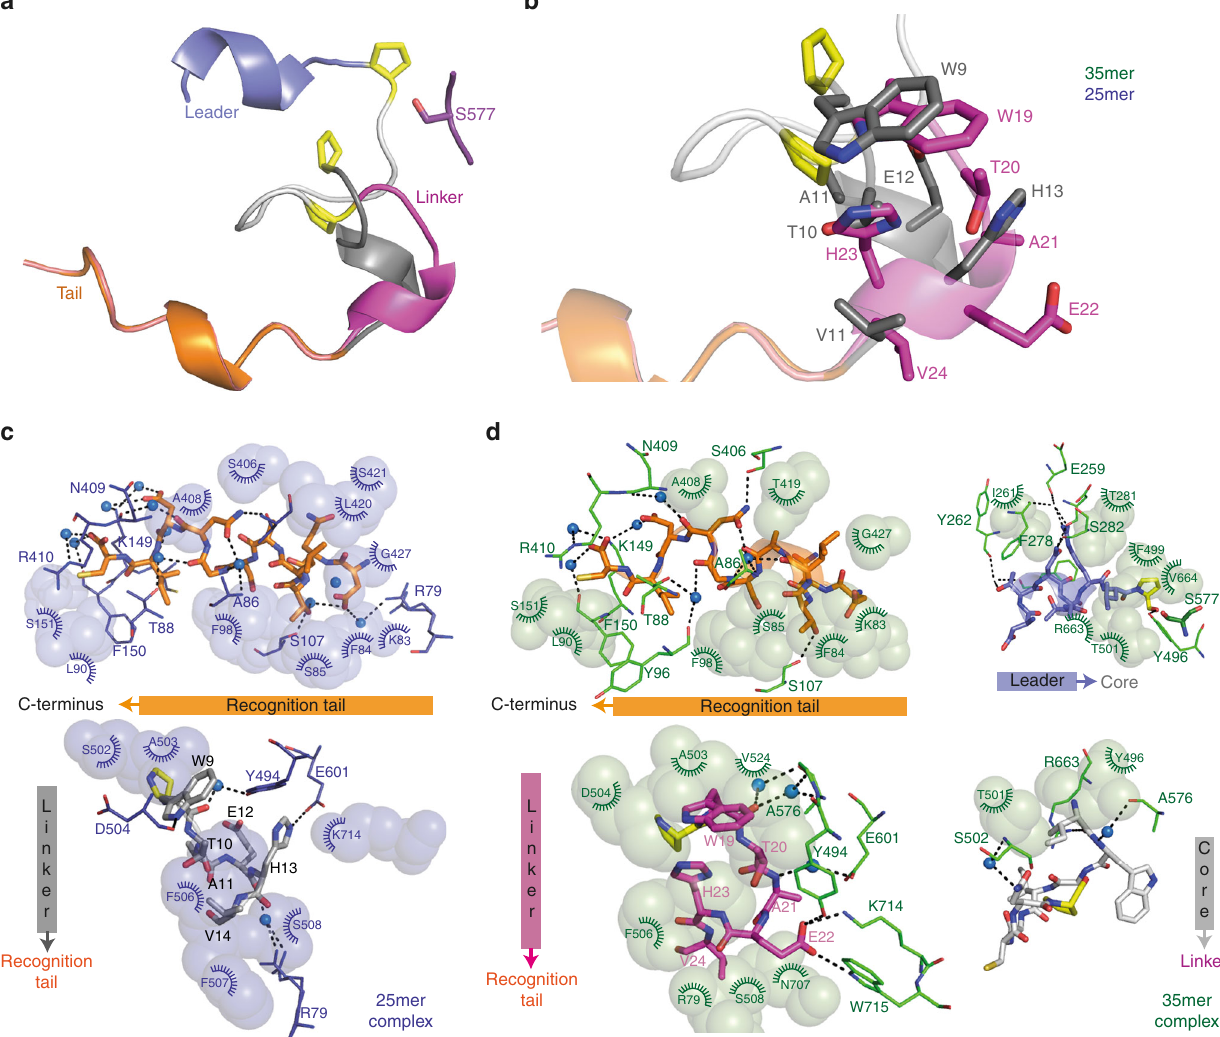
Fig. 2 Interactions between GmPOPB and linker regions for 35mer and 25mer substrates are different. a Overview of bound peptides. Colors for distinct peptide regions are as in Fig. 1b, except that the linker in the 25mer complex is in dark gray . Position of the catalytic Ser577, and core and leader proline residues ( yellow ) are indicated in sticks . b Comparison of the linker region between 35mer ( magenta ) and 25mer ( gray ) complexes. Highlighted are the very different position of Glu and His in contrast to tryptophan, which in both structures occupies the same pocket although the conformation is different. c Interactions between peptide tail and linker of the 25mer peptide and GmPOPB-S577A. Residues within hydrogen bonding distance are shown in lines , residues participating in hydrophobic interactions are in spheres , water molecules are depicted as small red spheres , prolines are shown in yellow . Color coding for peptide substrate regions follows a , residues from GmPOPB are depicted in blue . d Interactions between peptide tail, linker, core, and leader (anti-clockwise) of the 35mer peptide and GmPOPB-S577A. The same representation as c is used except residues from GmPOPB are depicted in